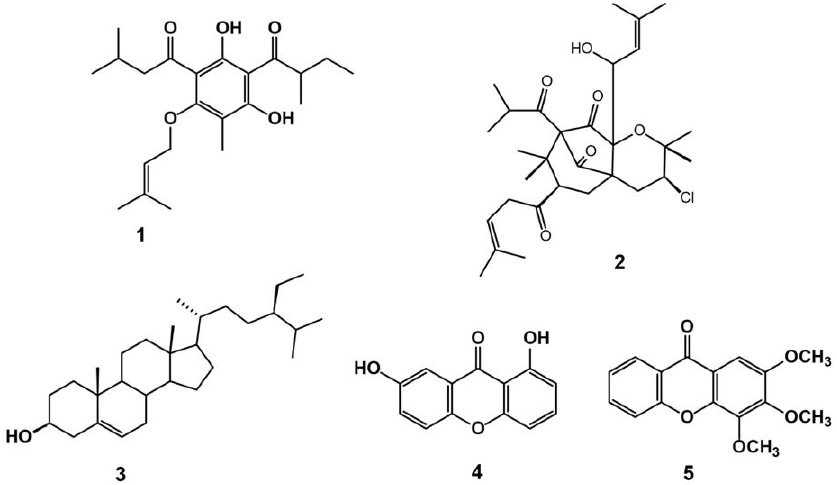
Figure 1. Chemical structures of isolated compounds 1 – 5 .